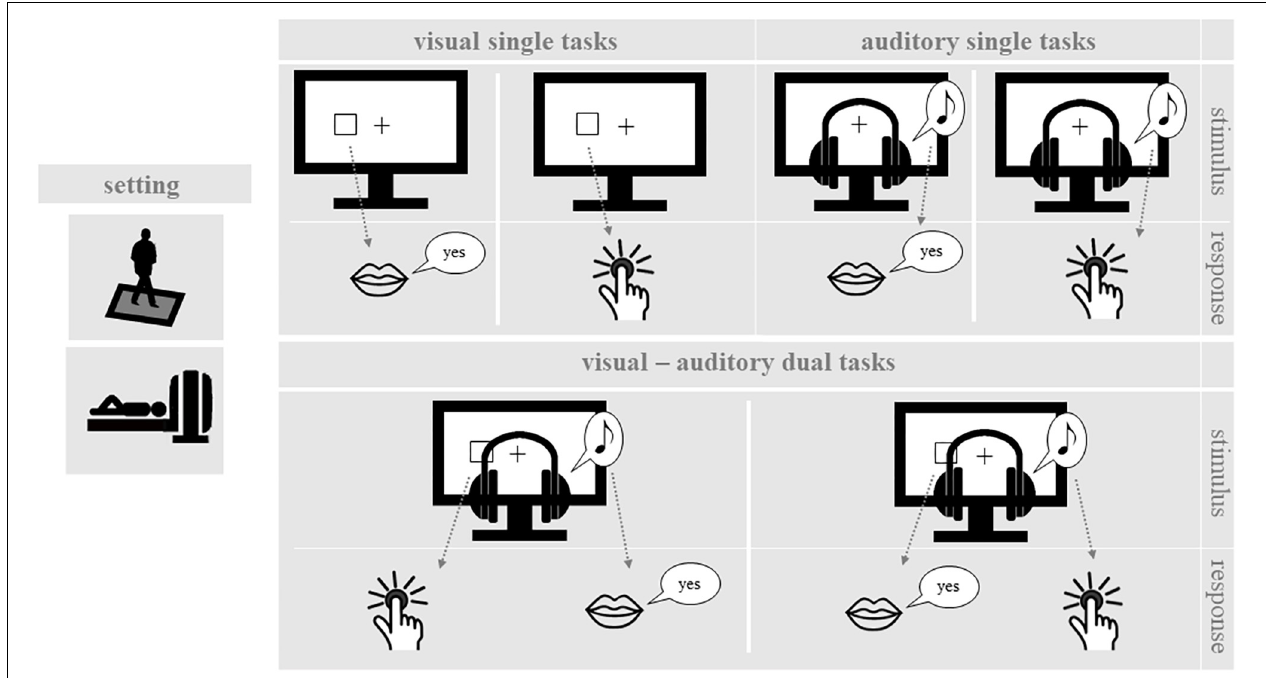
FIGURE 1 | One-back working memory tasks. In the single one-back tasks, participants decided for visual or auditory stimuli whether they are identical to the stimulus in the trial before. In the dual one-back tasks visual and auditory stimuli were presented simultaneously and participants made the one-back decision for both